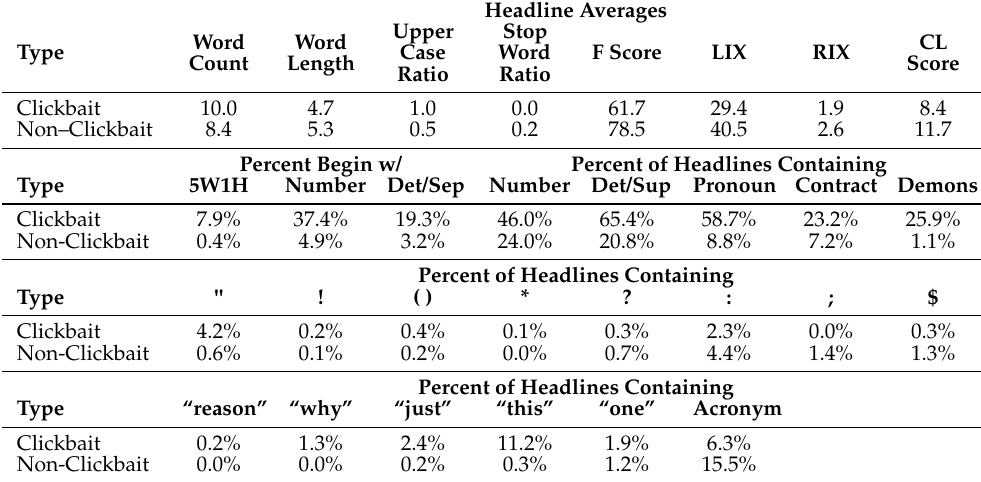
Table 2. Feature